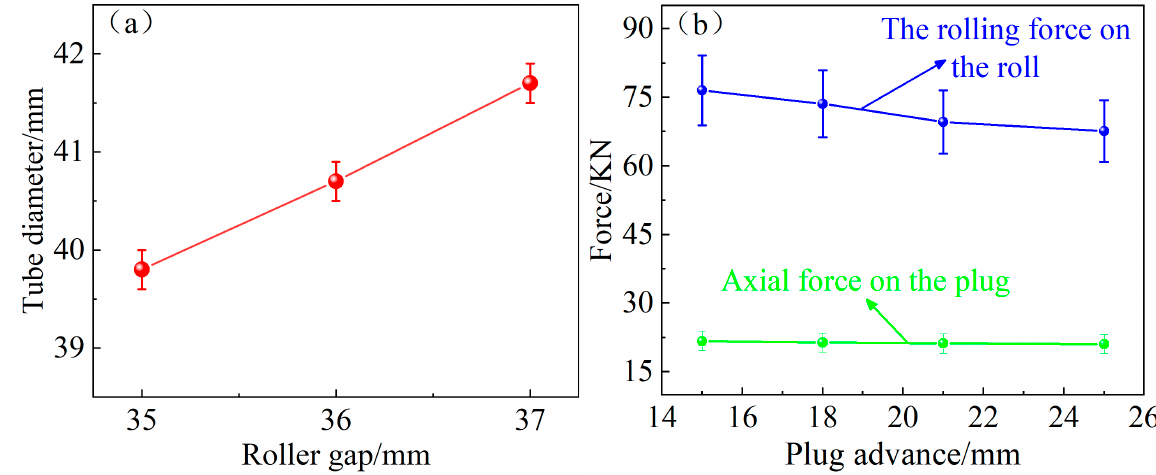
Figure 4. Influence of key parameters on piercing: ( a ) the roller gap; ( b ) the plug advance.